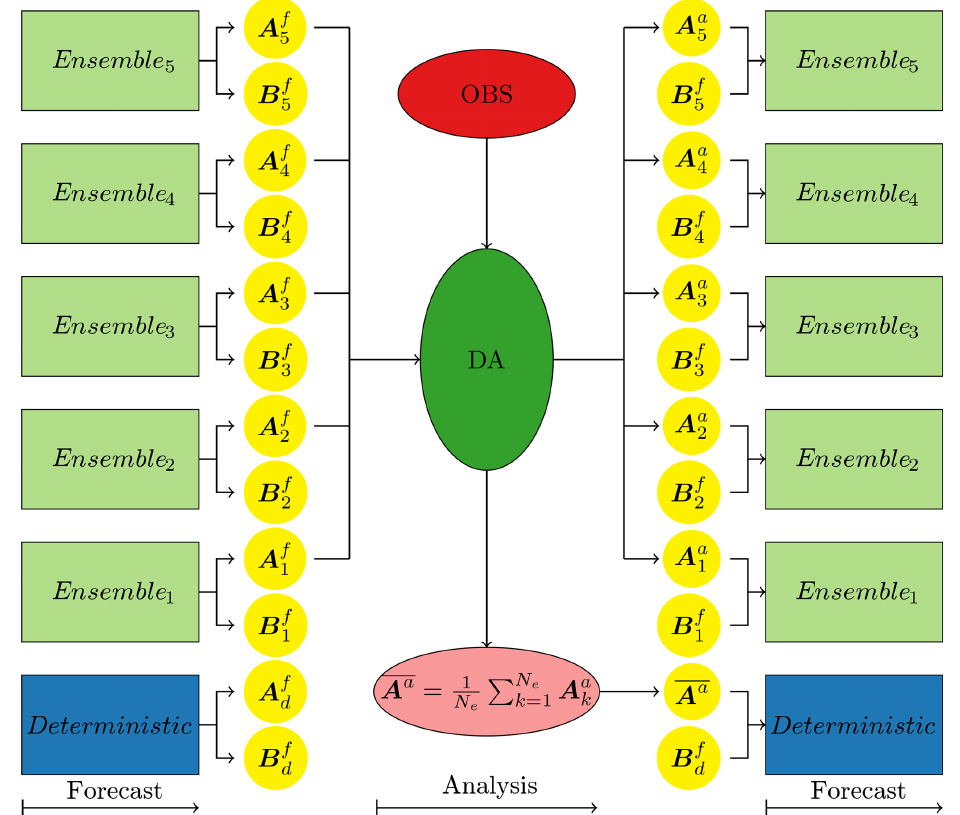
and B f , respectively. But the EnKF system only analyses and k k ... A a and the analysis mean A a . In this example, there are N e 1